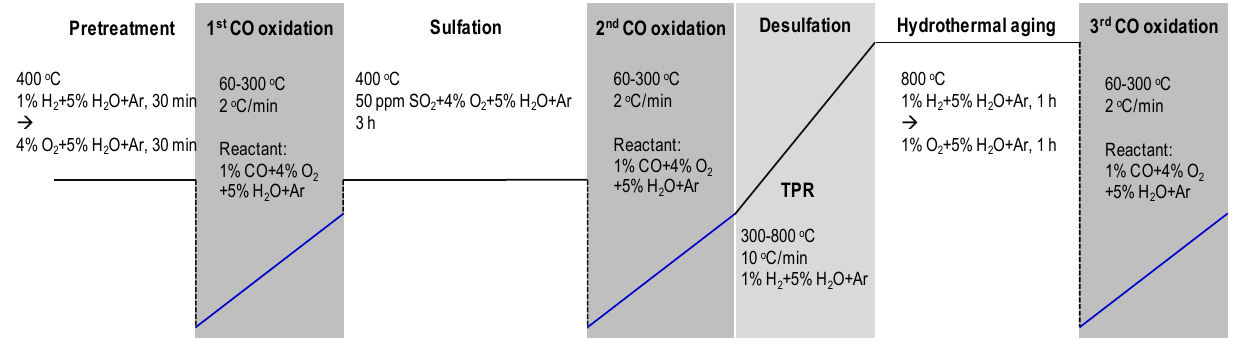
Figure 7. Sequence of reactor evaluation of catalysts including sulfation, desulfation, and hydrothermal aging